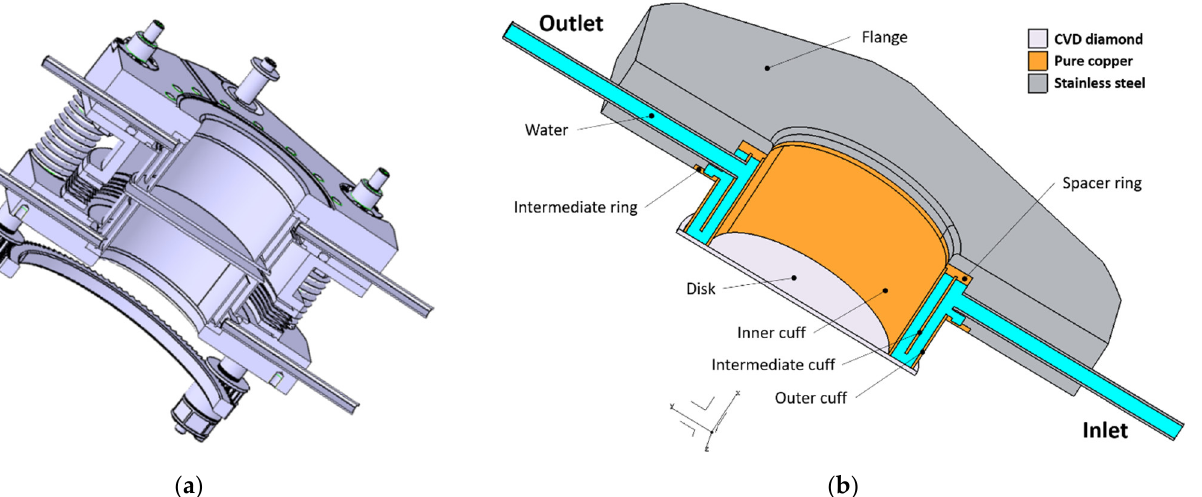
Figure 1. ( a ) Geometry of the double-disk window designed and manufactured for ASDEX Upgrade; ( b ) geometry of the window used in the analyses. Reference system, nomenclature of the main parts and materials are shown.